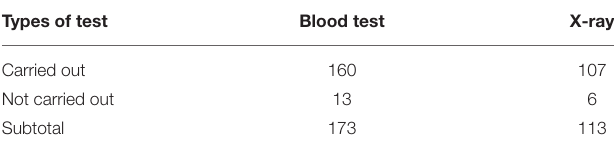
TABLE 2 | Tests ordered for the 638 patients observed at